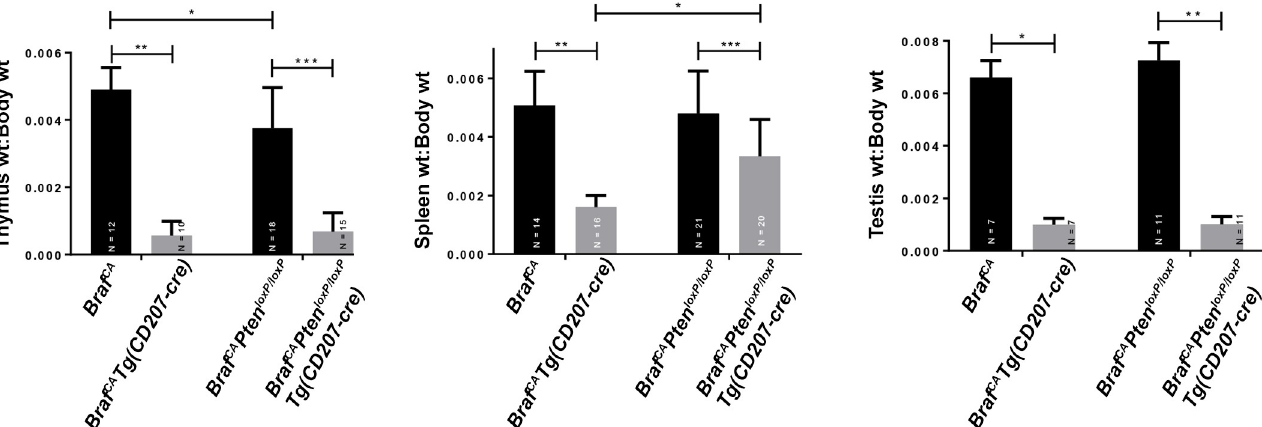
Fig 11. Organ size in genetically modified mice. Thymus, spleen, and testis weights were determined relative to the body weights of the mice of the indicated genotypes from which they were derived. The decreased weights of thymus and testis in Braf CA Pten loxP/loxP Tg(CD207-cre) compared to controls was similar to the decrease seen in Braf CA Tg(CD207-cre) mice. However, spleen weight was closer to controls in Braf CA Pten loxP/loxP Tg(CD207-cre) mice compared to Braf CA Tg(CD207-cre) mice (middle panel). Numbers of mice tested are indicated. Braf CA Pten loxP/loxP Tg(CD207-cre) and Braf CA Tg(CD207-cre) mice ranged in age from 28 to 54 days. Braf CA Tg(CD207-cre) and Braf CA mice are the same as shown in Fig 4. Comparisons made by two-sided Welch t-test: left panel (thymus): � , p = 2.26 x 10 − 3 ; �� , p = 8.85 x 10 − 14 ; ��� , p = 7.02 x 10 − 10 ; middle panel (spleen): � , p = 4.96 x 10 − 6 ; �� , p = 1.43 x 10 − 8 ; ��� , p = 1.30 x 10 − 3 ; right panel (testis): � , p = 3.69 x 10 − 8 ; �� , p = 1.98 x 10 − 13